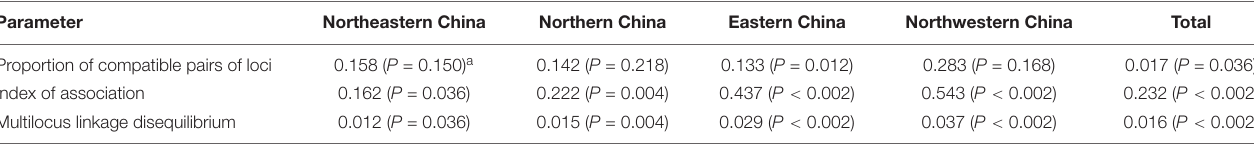
TABLE 6 | Proportion of compatible pairs of loci (PrCompat), index of association ( I A ), and multilocus linkage disequilibrium ( r d ) for Chinese populations of Alternaria tenuissima obtained from infected tomato leaves.